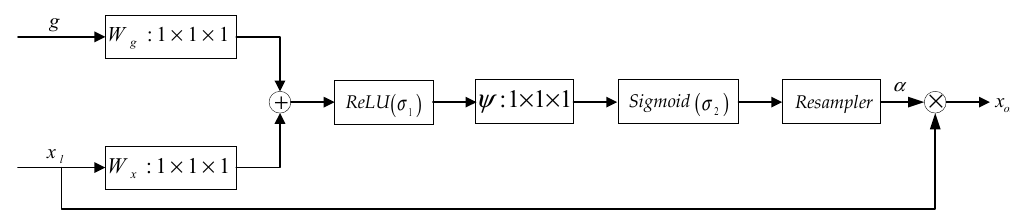
Figure 8. The structure diagram of the Attention Gate.